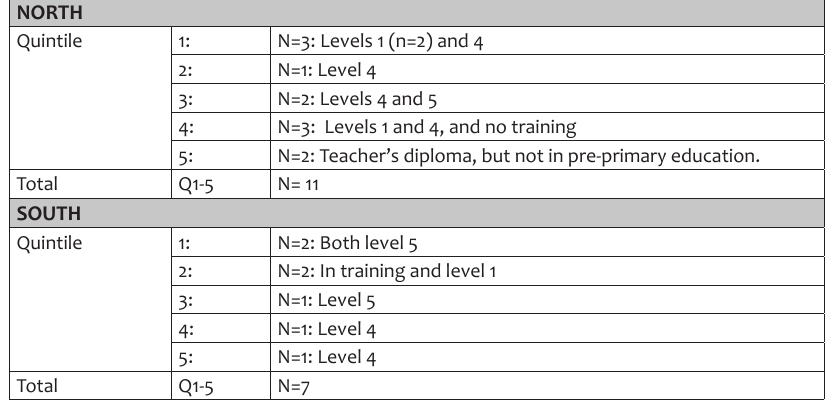
Table 4: Training of teachers